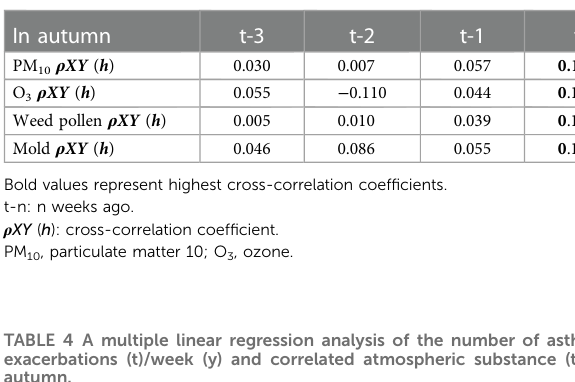
TABLE 3 Cross-correlation coef fi cients between the number of asthma exacerbations (t) and atmospheric substance (t-n) in autumn. In autumn